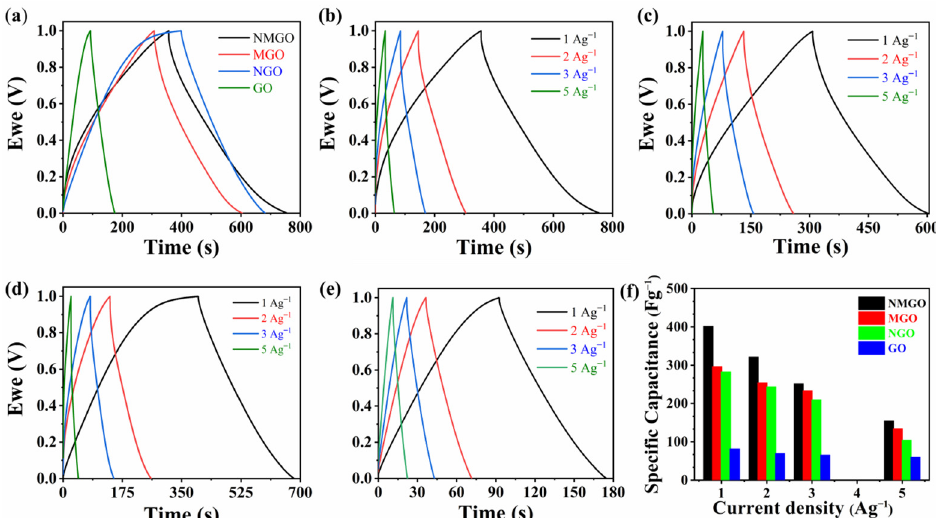
Figure 4. ( a ) Comparison of galvanostatic charge and discharge curve at the current density of 1 A · g − 1 between NMGO, MGO, NGO, and GO; galvanostatic charge and discharge curve of ( b ) NMGO, ( c ) MGO, ( d ) NGO, and ( e ) GO; and ( f ) comparison of specific capacitance calculated by galvanostatic charge and discharge at different current densities between NMGO, MGO, NGO, and GO.